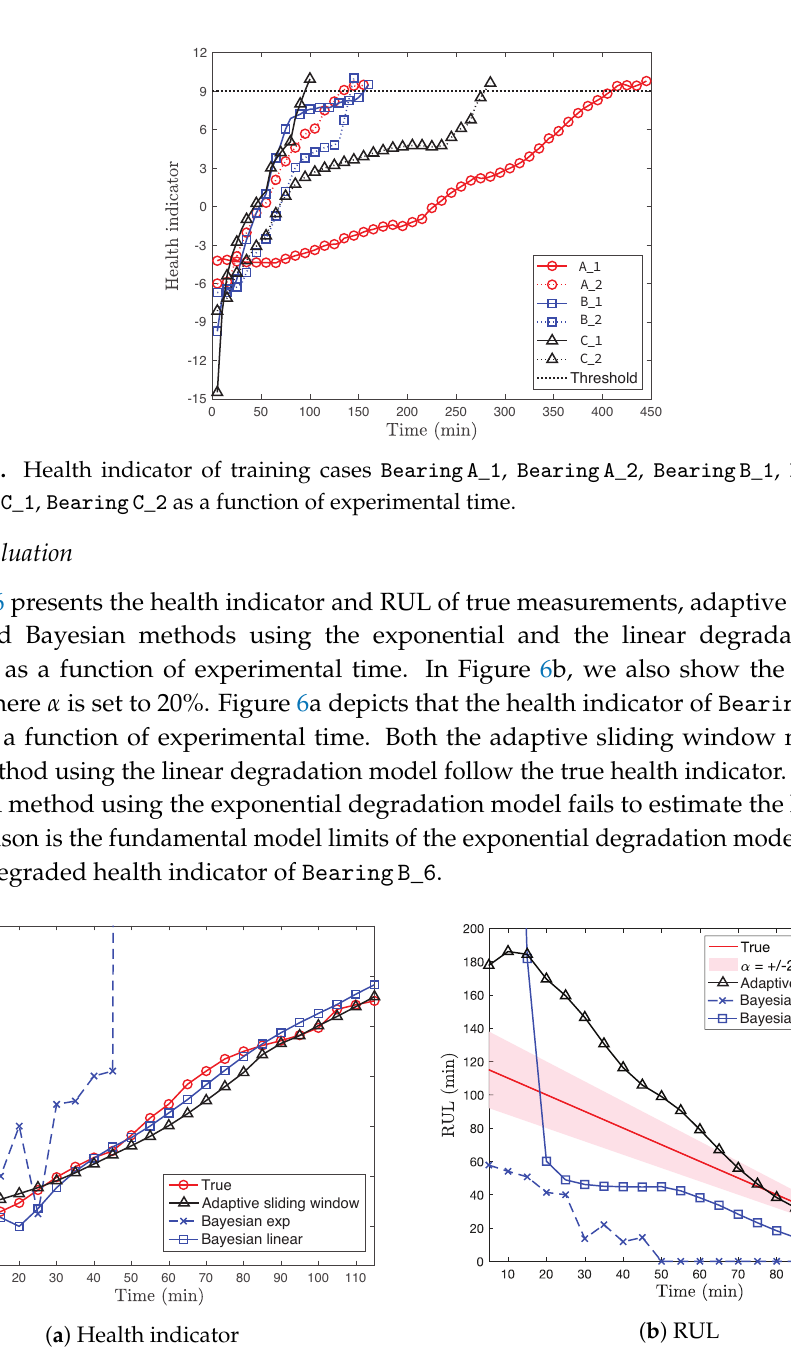
Figure 6. Health indicators and RUL of true measurements, adaptive sliding window method, and Bayesian methods using the exponential and the linear degradation models of Bearing B _ 6